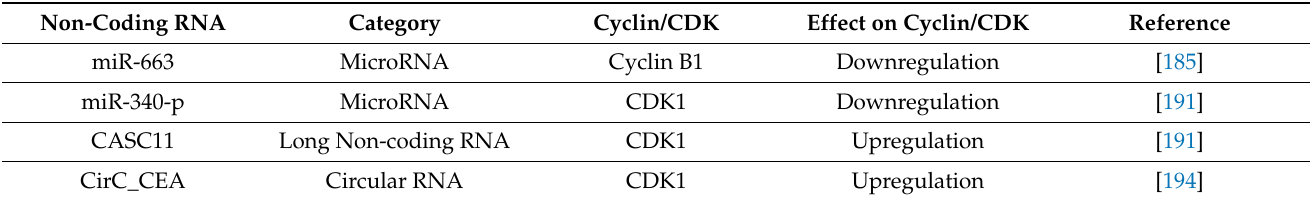
Table 7. Non-coding RNAs targeting the Cyclin B1CDK1 axis in gastric cancer are